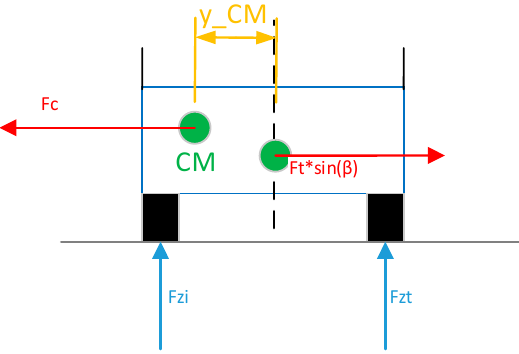
Figure 16. Calculation of the loads on the wheels in motion. YZ plane.